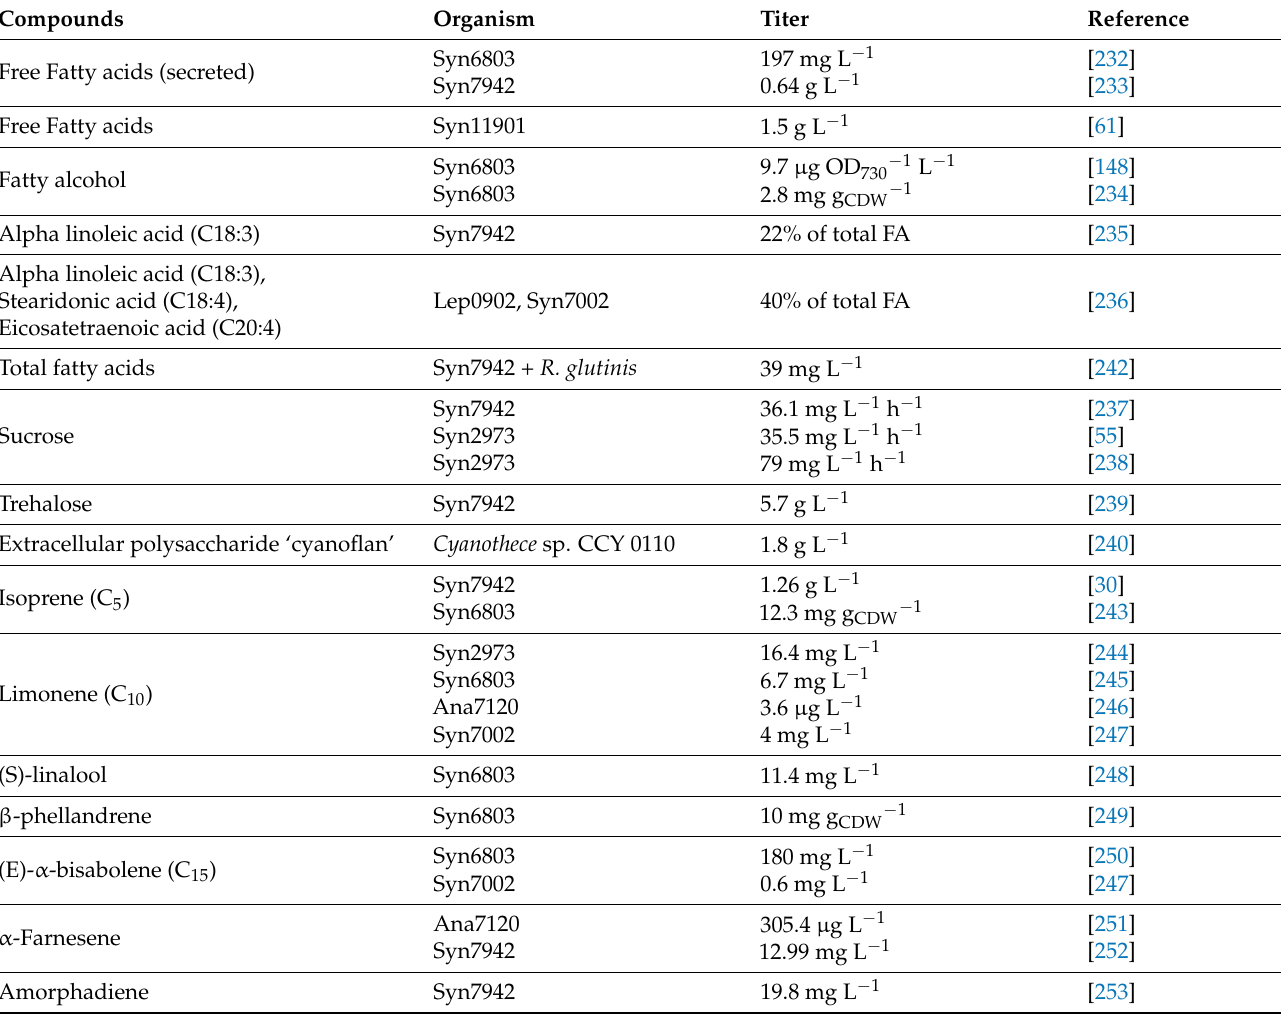
Table 2. Compound titers and relative cyanobacterial